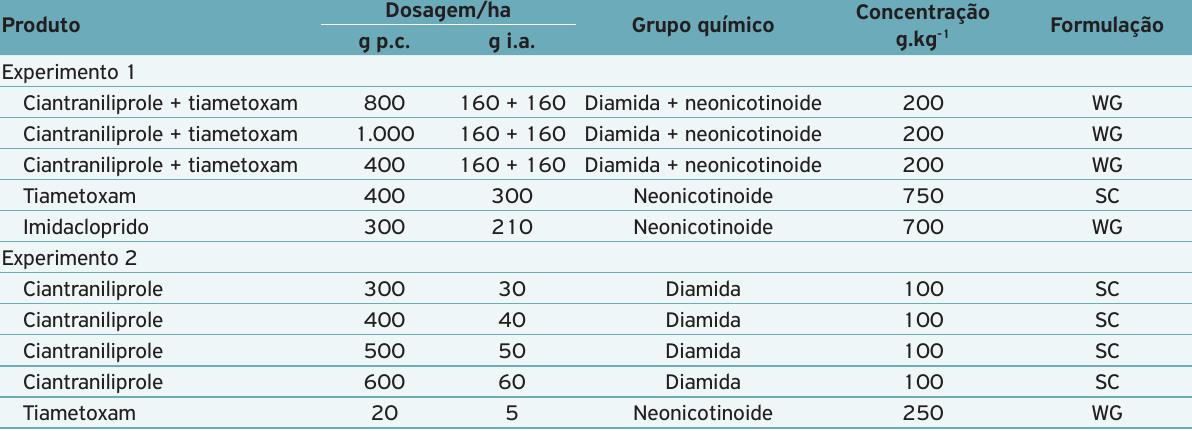
Tabela 1. Produtos químicos, dosagens, grupos químicos, concentrações e formulações utilizados nos experimentos 1 e 2 na cultura do tomateiro ( Lycopersicon esculentum Mill.).